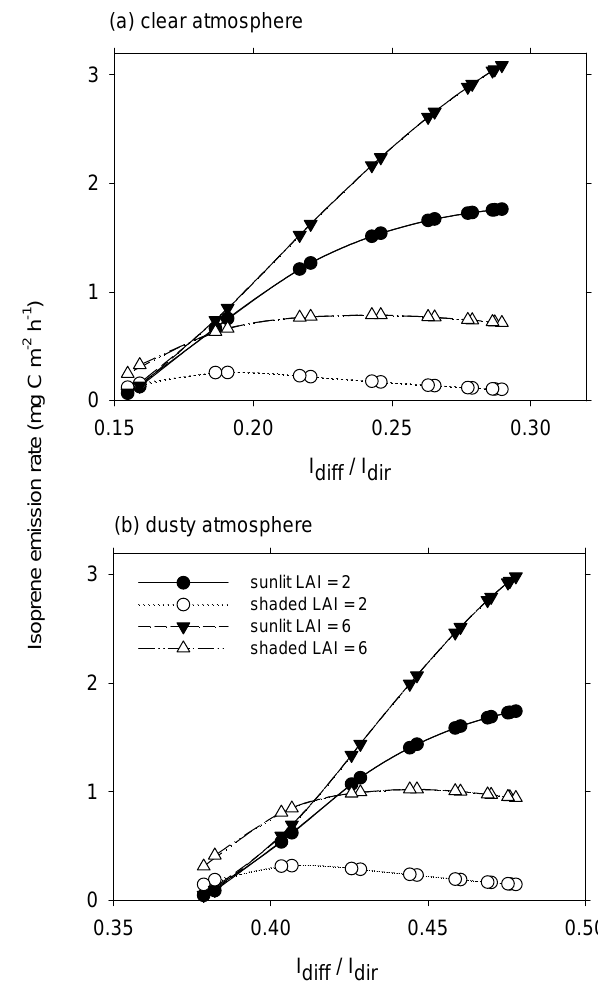
Fig. 7. Variation in isoprene emission rates with respect the ratio I diff /I dir for ( a ) a clear atmosphere and ( b ) a dusty Figure 7 (Wilton et al. )